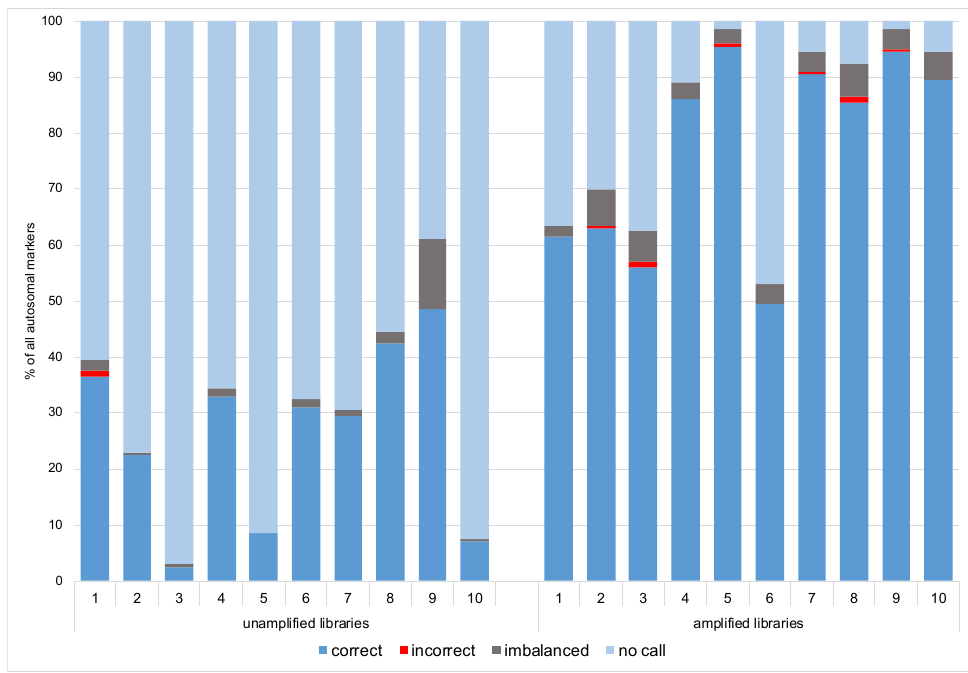
Figure 5. Genotyping rate per each sample across all 200 markers for unamplified and amplified single-cell-based libraries.